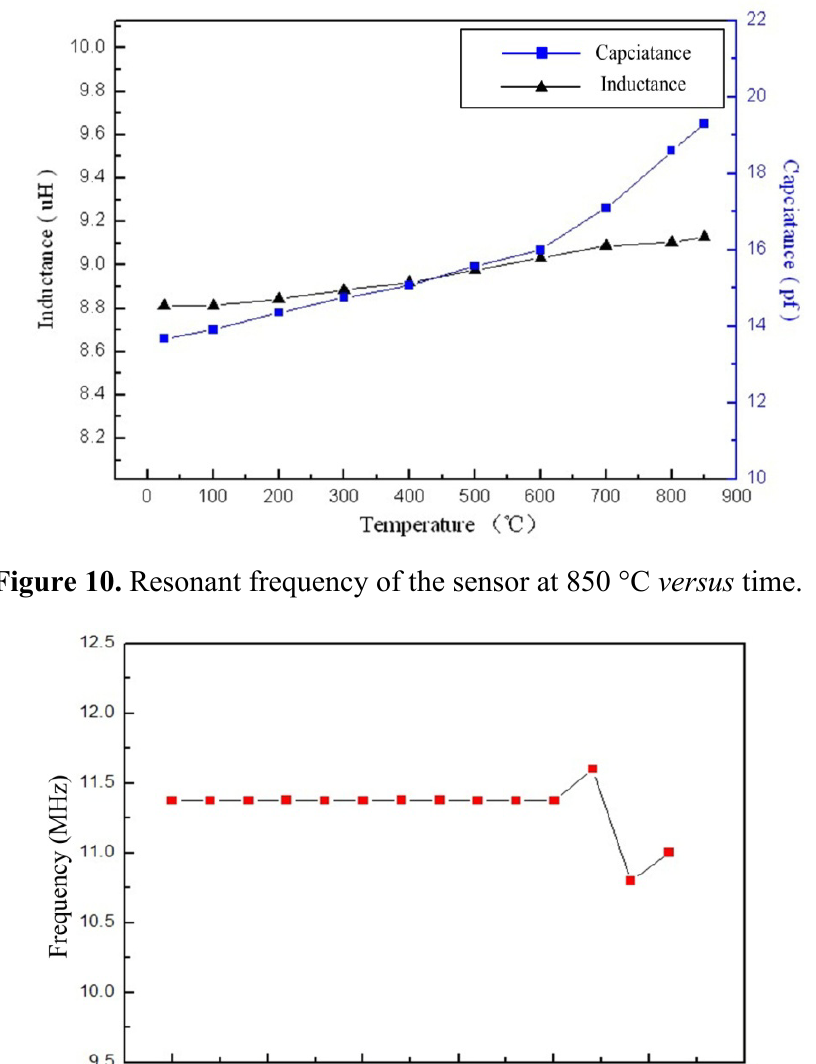
Figure 9. Change of inductance L and variable capacitance Cs versus temperature for the sensor.